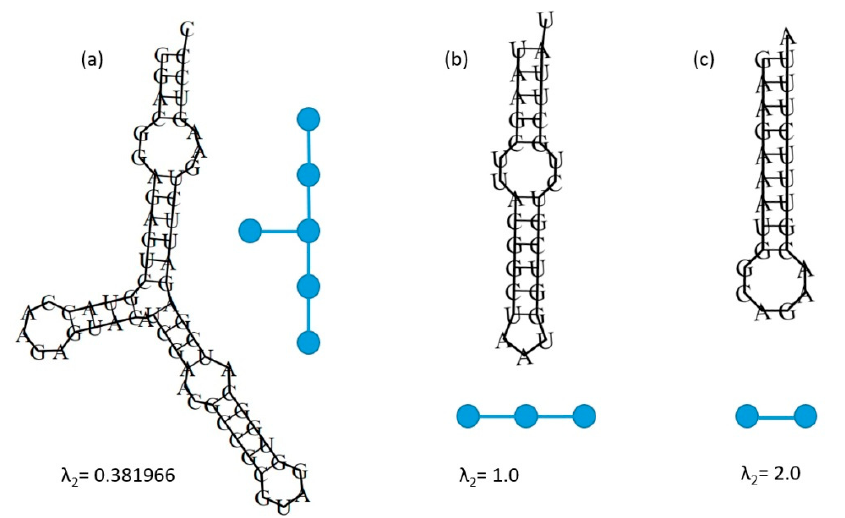
Figure 1. Three possible tree-graph topologies and their Laplacian second smallest eigenvalue (algebraic connectivity). ( a ) A case of six nodes with an algebraic connectivity of 0.381966. ( b ) A case of three nodes with an algebraic connectivity of 1.0. ( c ) A case of two nodes with an algebraic connectivity of 2.0.